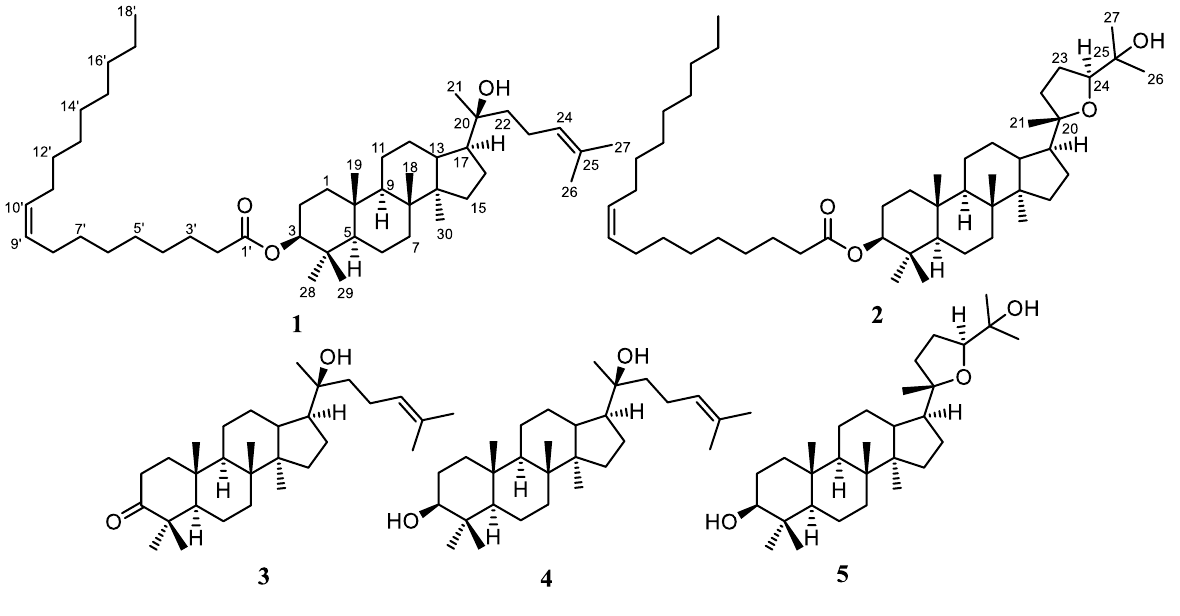
Figure 1. Structure of compounds 1 – 5